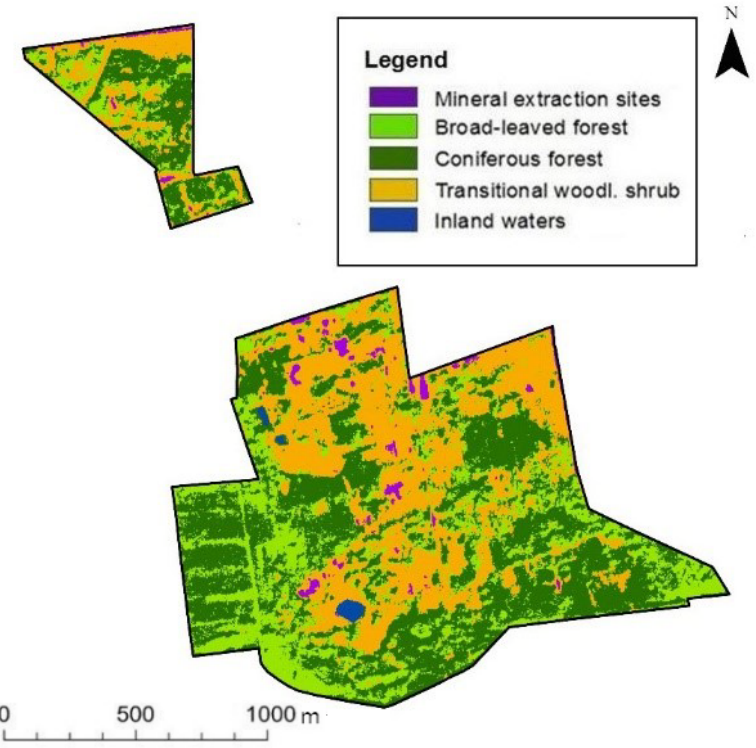
Figure 7. The results (random trees method) of image classification cropped to the Jeziórko research area.